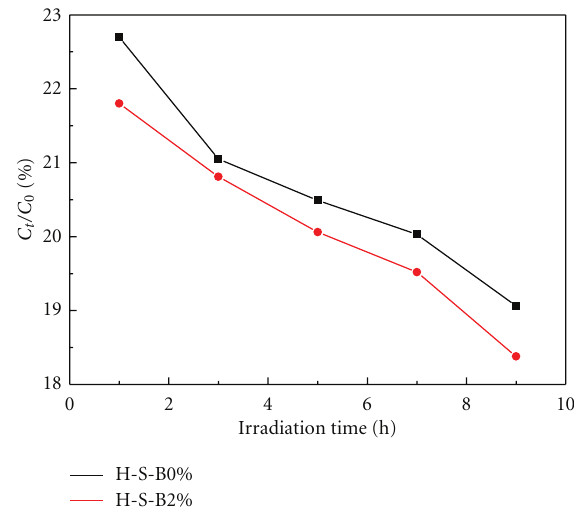
Figure 4: UV-visible light reflection spectrum of hematite and B- doped hematite.